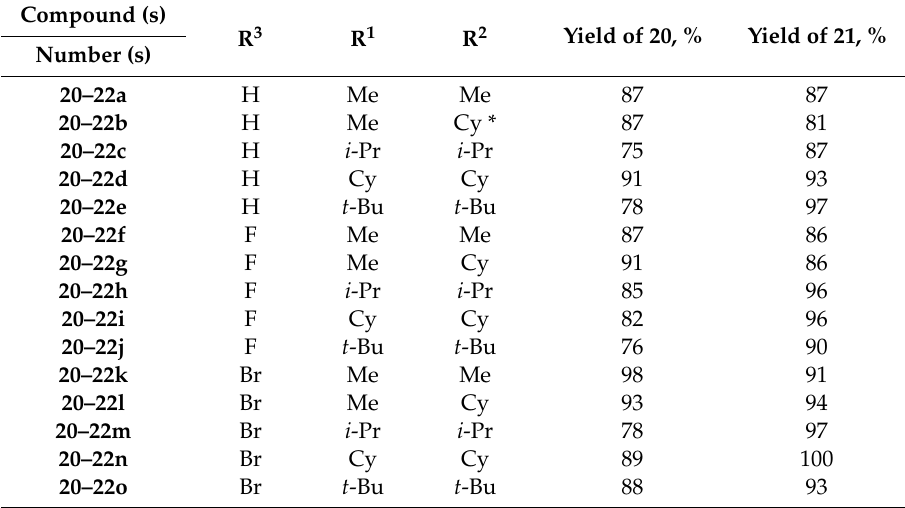
Table 1. The library of new compounds prepared in this study.